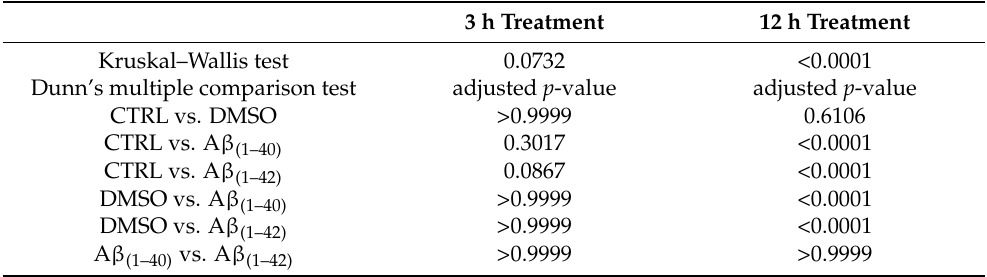
Table 1. List of the statistically adjusted p -value (from Figure 1B,C) between separate groups (CTRL, DMSO, A β (1–40) and A β (1–42) ) after 3 h and 12 h of treatment conditions. A Kruskal–Wallis test was performed, followed by a Dunn’s multiple comparison test. 3 h Treatment 12 h Treatment Kruskal–Wallis test 0.0732 <0.0001 adjusted p -value adjusted p